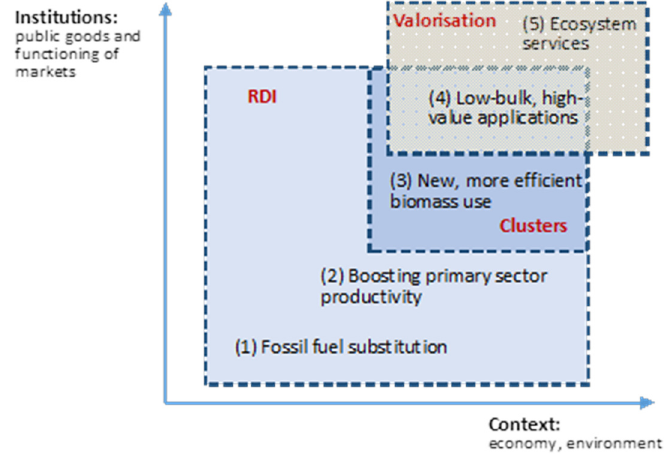
Figure 1. Contexts (axes), specific drivers (in bold), and transition pathways (1–5) (own elaboration).